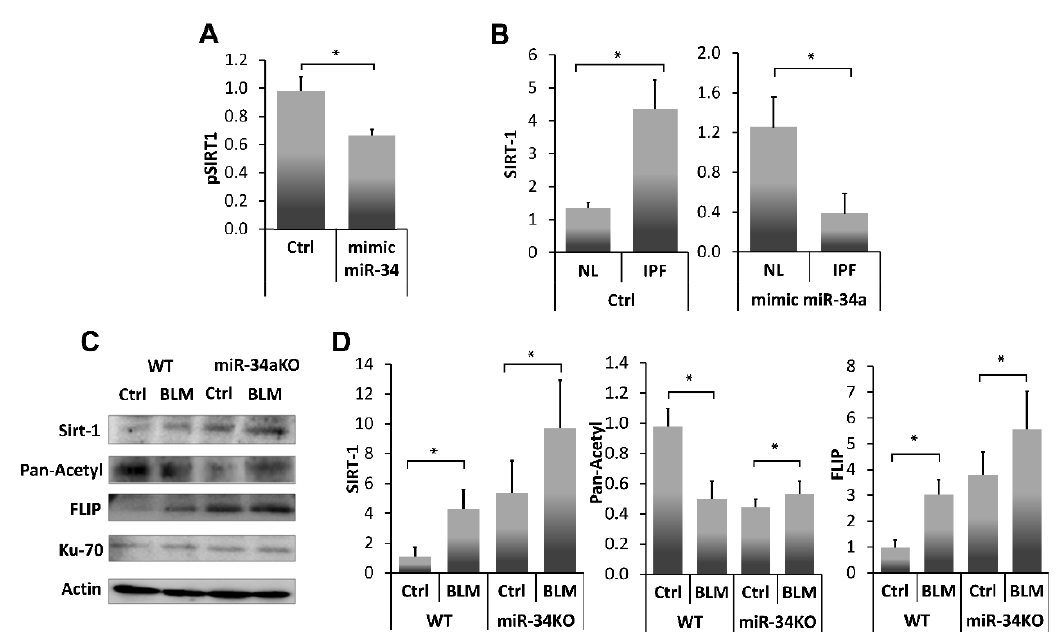
Figure 4. SIRT1 levels, and activity, in fibrotic-lung myofibroblasts, can be regulated by a miR-34a mimic. ( A ) Luciferase reporter assay using a Mitras laminator. PmirGLO-hSIRT1 (pSIRT1)-transfected 293-T cells treated with control or mimic-miR34a (200 nM, 72 h) (Ctrl vs. mimic miR34, respectively). ( B ) SIRT1 expression (qPCR), in cells from fibrotic / IPF vs. normal-lung (NL) myofibroblast cell lines, following miR-34a control (200 nM, 72 h) exposure ( B , Left panel, saline (Ctrl) in NL and IPF), and after exposure ( B , Right panel, mimic miR34a in NL and IPF). Fibroblasts were isolated from lungs of Ctrl-or BLM-treated WT and miR34a knockout mice. ( C ) Ku70 IP with subsequent IB and, ( D ) graphical presentation of optical density (OD) ratios to β-actin (the product of a housekeeping gene) for SIRT-1, pan-acetyl, and FLIP. Representative from four independent experiments, n = 4–6. * p < 0.01–0.05.